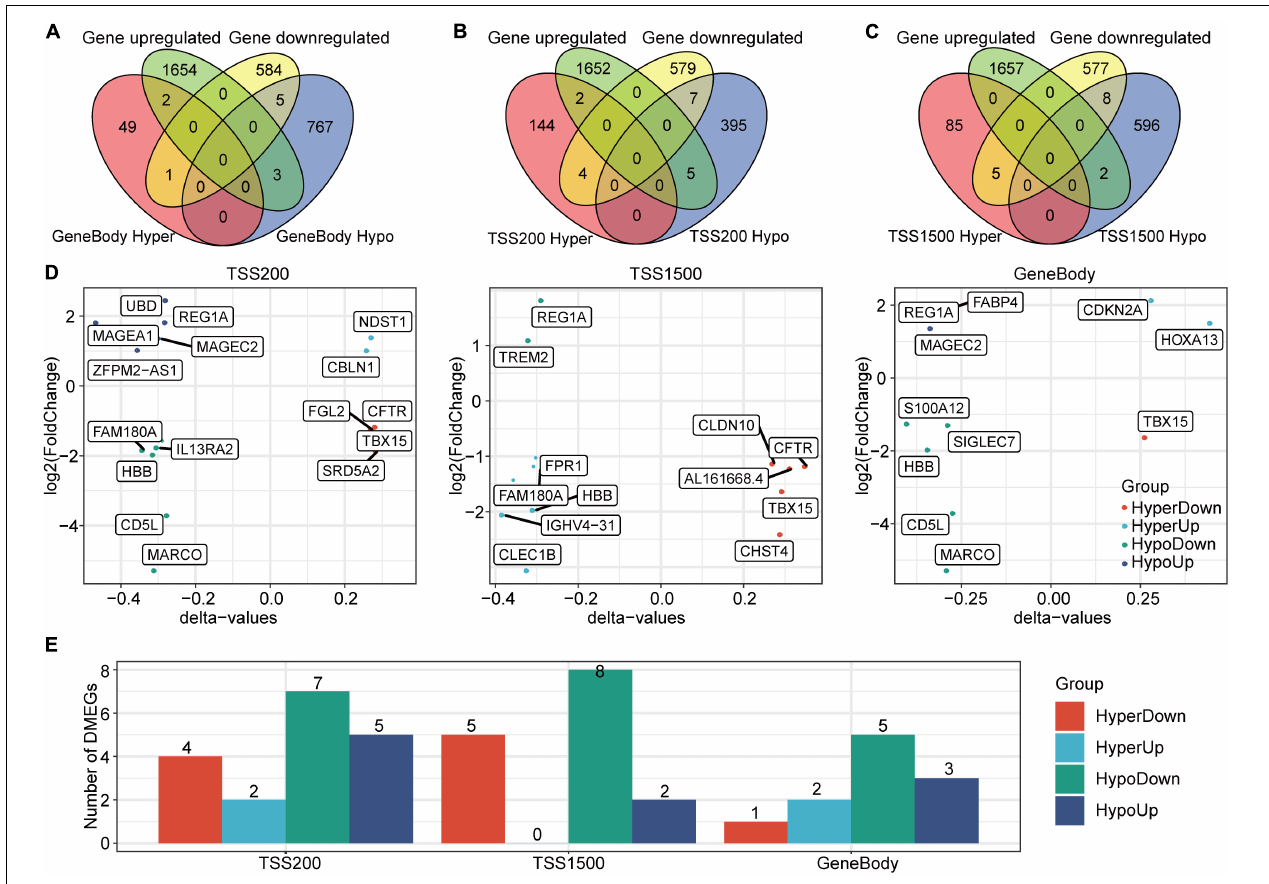
FIGURE 4 | Identification and expression patterns of DMEGs. (A) A Venn diagram of the DEGs and the DMGs in gene body regions. (B) A Venn diagram of the DEGs and the DMGs in TSS200 regions. (C) A Venn diagram of the DEGs and the DMGs in TSS1500 regions. (D) Distribution of the four DMEG expression modes in the three regions. (E) A histogram of the four DMEG regulatory modes in the three